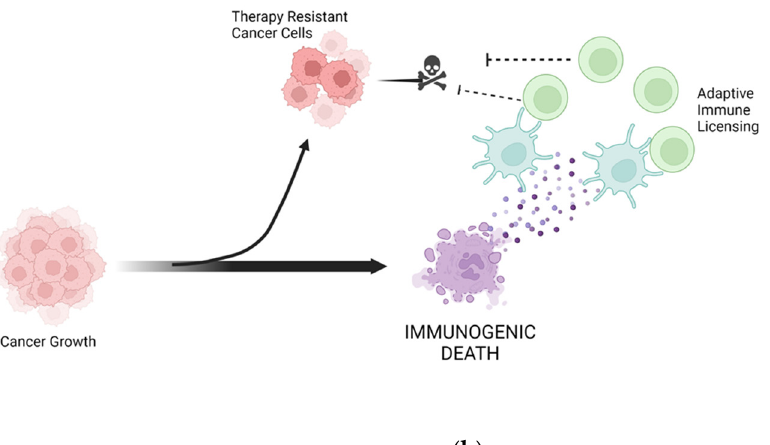
Figure 4. Engaging immunogenic death programs to circumvent therapeutic resistance. ( a ) Many cancer therapeutics are designed to elicit apoptosis, a physiological death program that cancer is inherently able to resist. In some cases, Immunogenic Cell Death (ICD) may develop during apoptosis and promote antitumor immunity, but this phenomenon is poorly understood. Therapy-resistant cancer is inevitable following conventional chemotherapy and eventually seeds relapse sites.